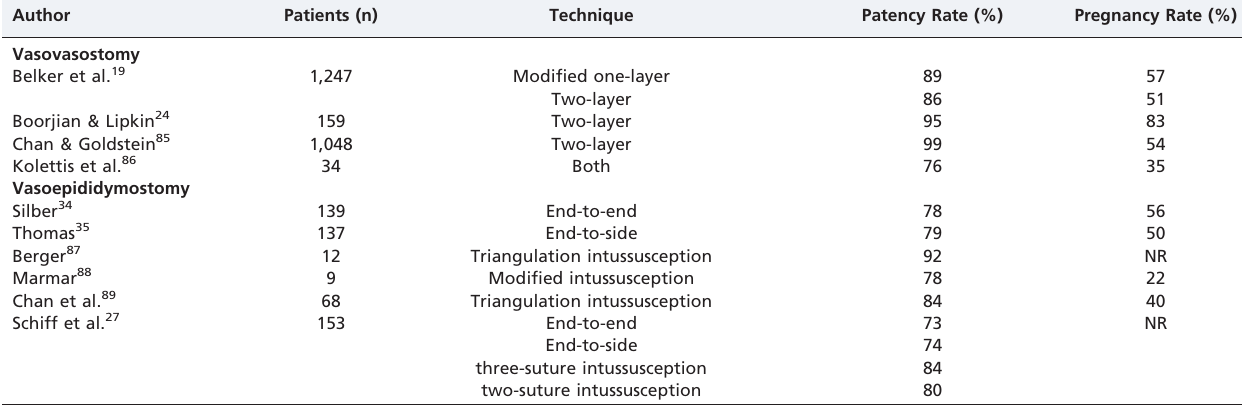
Table 2 - Treatment Results for Vasovasostomy and Vasoepididymostomy. Type of Anastomosis, Patency, and Spontaneous Pregnancy Rates using Various